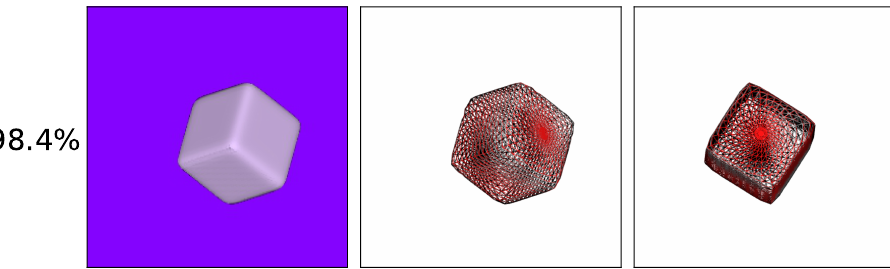
Figure 9. Examples of superquadric reconstructions from across the whole IoU distribution range. The first column depicts input images, while the second and third show the overlap between ground truth (red) and predicted (black) superquadrics in wireframe form, from two different viewpoints.